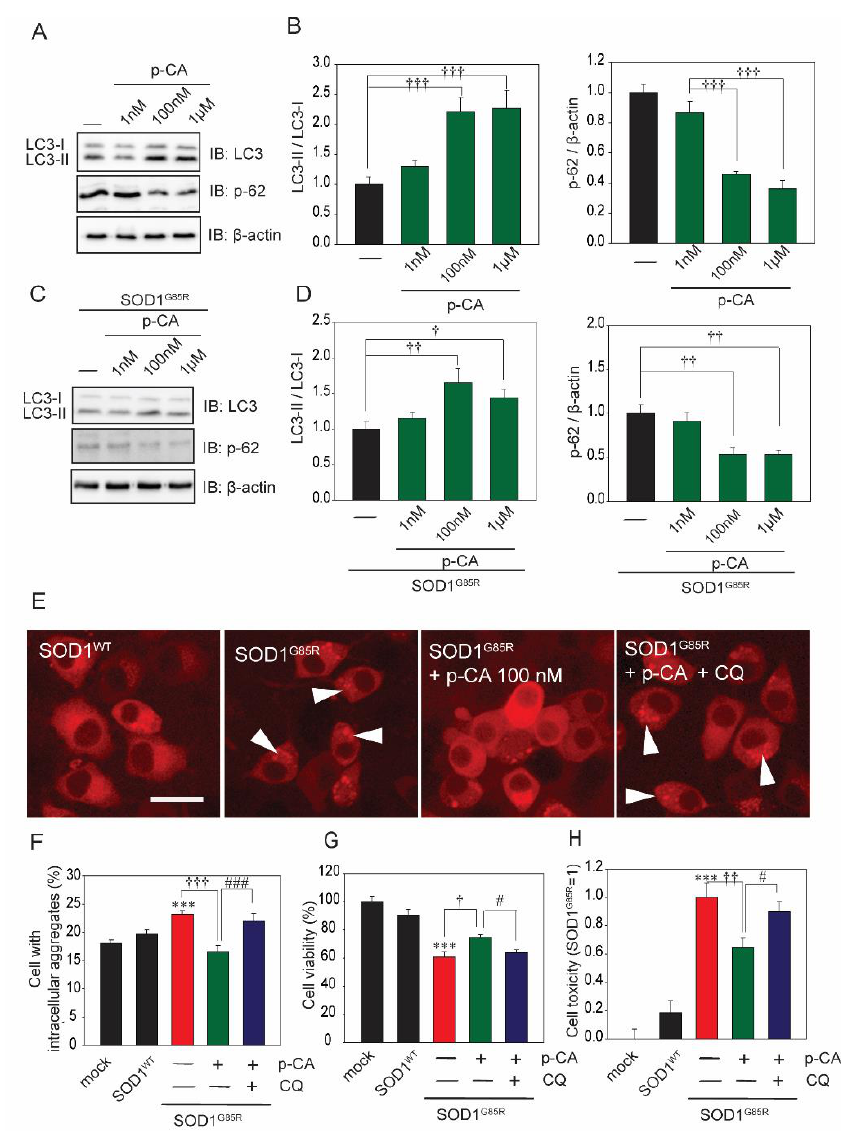
Figure 4. p-CA prevented SOD1 mut -associated neurotoxicity through autophagy. ( A ) Immunoblot analysis of LC3 and p62 relating to autophagy. ( B ) Densitometric quantification of LC3 and p62. ††† p < 0.001 vs. control. ( C ) Immunoblot analysis of LC3 and p62 relating to autophagy with SOD1 G85R -expressing cells. ( D ) Densitometric quantification of LC3 and p62. ††† p < 0.001 vs. control. ( E ) Imaging of cytoplasmic mCherry–SOD1 aggregates (white arrowheads) in the N2a cells with CQ (1 nM) before p-CA (100 nM) treatment. ( F ) Quantified analysis of imaging. (G) Cell viability was measured by MTT assay. (H) Cell toxicity was measured by LDH assay. Differences were evaluated by one-way ANOVA (mean ± SEM, n = 3). *** p < 0.001 vs. SOD1 WT , ††† p < 0.001, †† p < 0.01, † p < 0.05. vs. SOD1 G85R , ### p < 0.001, # p < 0.05. vs. SOD1 G85R + p-CA. Scale bar: 10 µm. p-CA: p-coumaric acid, CQ: chloroquine.